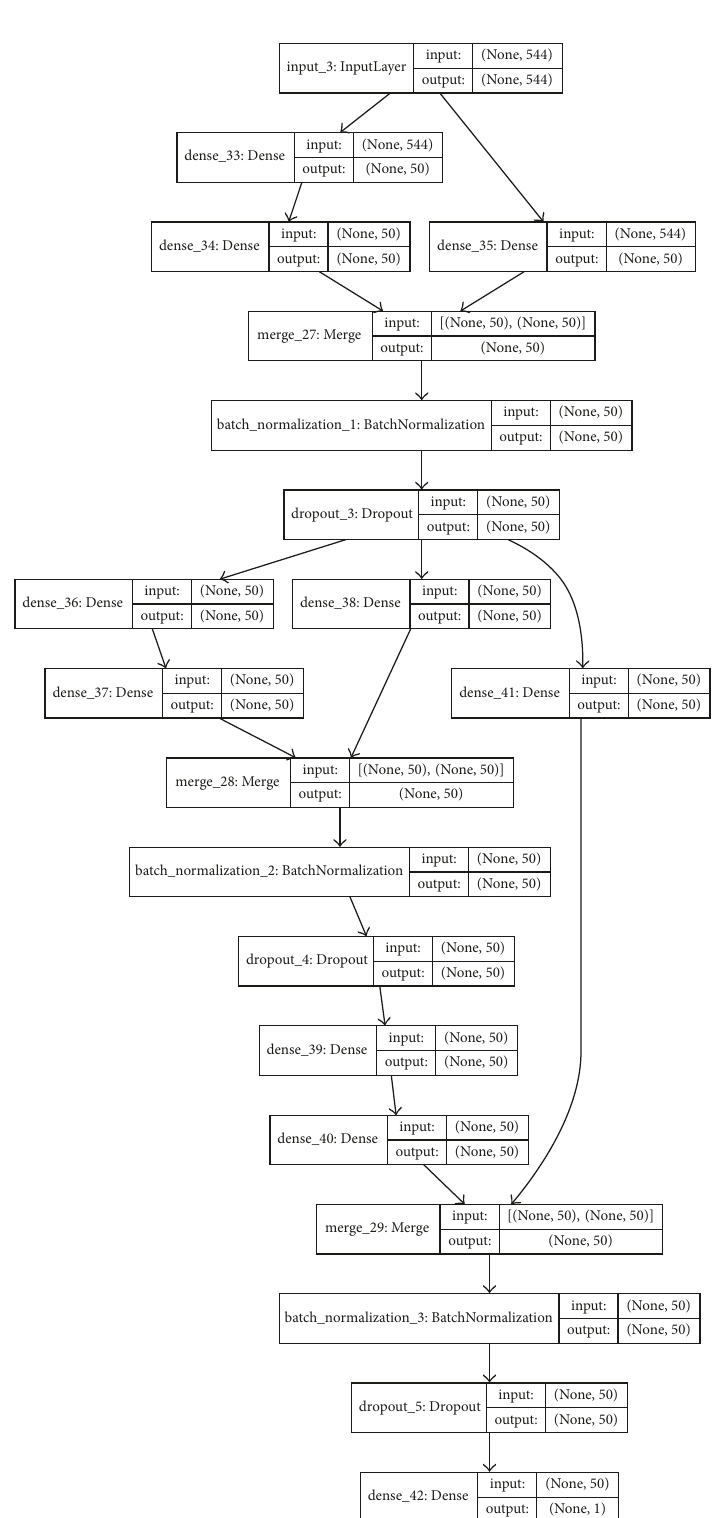
Figure 1: Sample residual skip-connection based network. The “merge 3” layer is the best node of the network for demonstrating the skip connections as adopted from [22]. “merge 3” layer performs an element-wise sum operation on the outputs of “dense 8” and “dense 9”, thus effectively allowing easier gradient backpropagation during